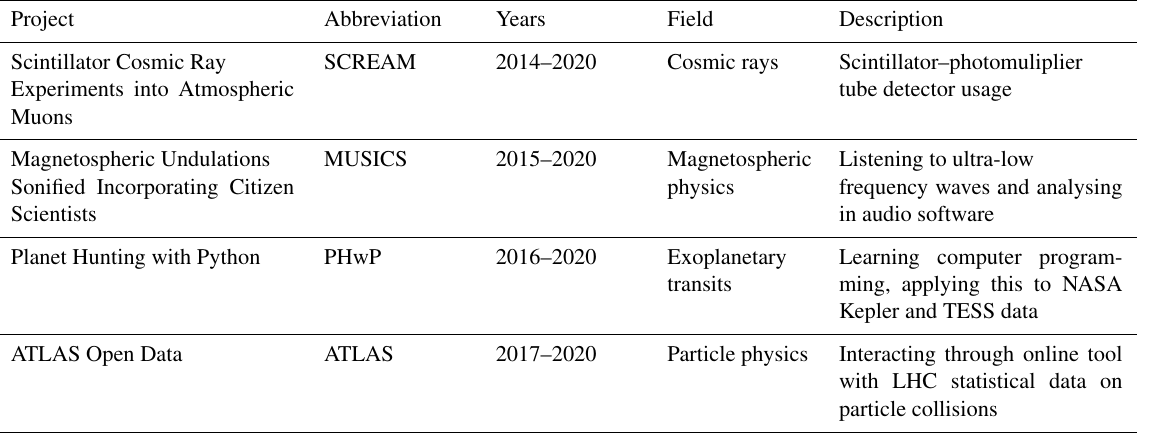
Table 1. A summary of the existing PRiSE projects at